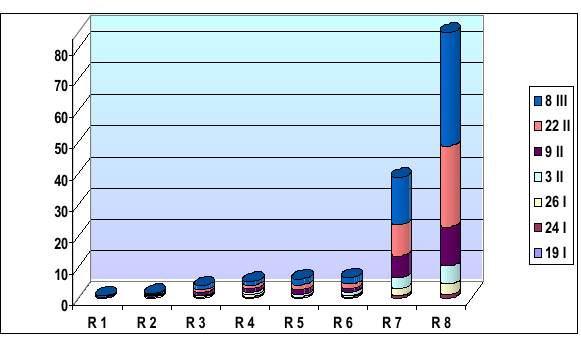
Fig. 2. Final average length of the shoots, in cm, resulting from the various buds according to their row of insertion Tab. 1. Growth stocks average of the shoots, in cm Dates of Number of rope